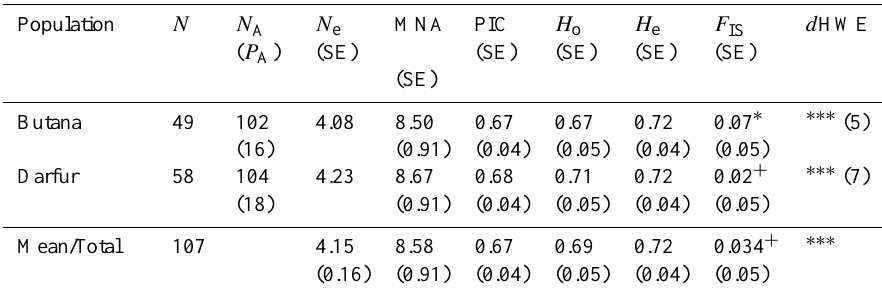
Table 3. Genetic diversity parameters and mean values within Sudanese camel